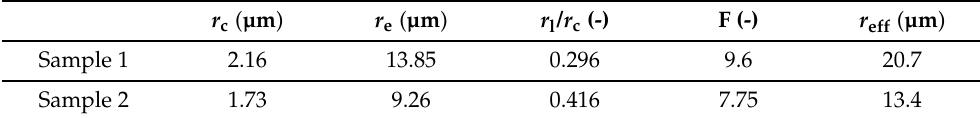
Table 2. Effective pore radii, depending on the respective approaches [30] describes the effective capillary pressure without an additional correction, using the geometric radius r c . [19], and [12] describes the capillary pressure with the effective radius r e , using r e = 2 · r h . The value r eff is based on the correction factor F , presented in Equation